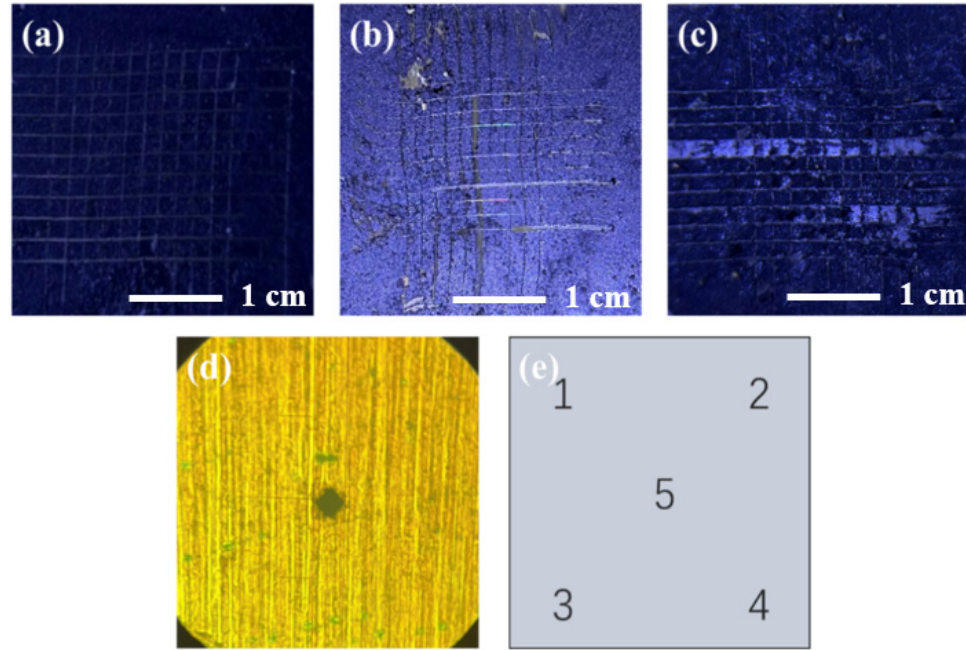
Figure 4. Adhesion test of sample 0 ( a ), sample4 ( b ), and sample 6 ( c ) and hardness test physical map ( d ), four-point probe measurement position ( e ).